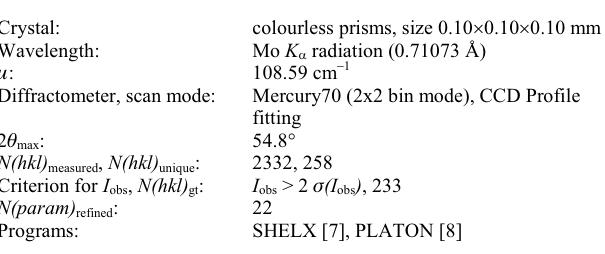
Table 1. Data collection and